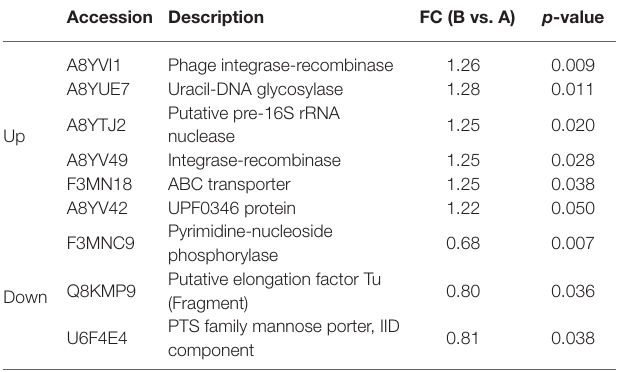
TABLE 4 | GO enrichment analysis of DEPs in B vs.